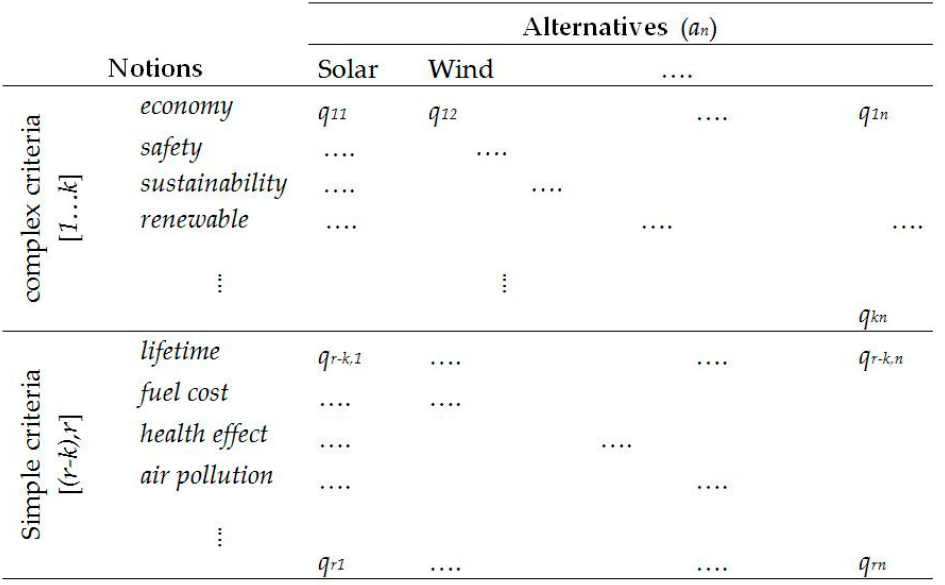
Figure 1. A section of the survey with the mathematical notations of variables.